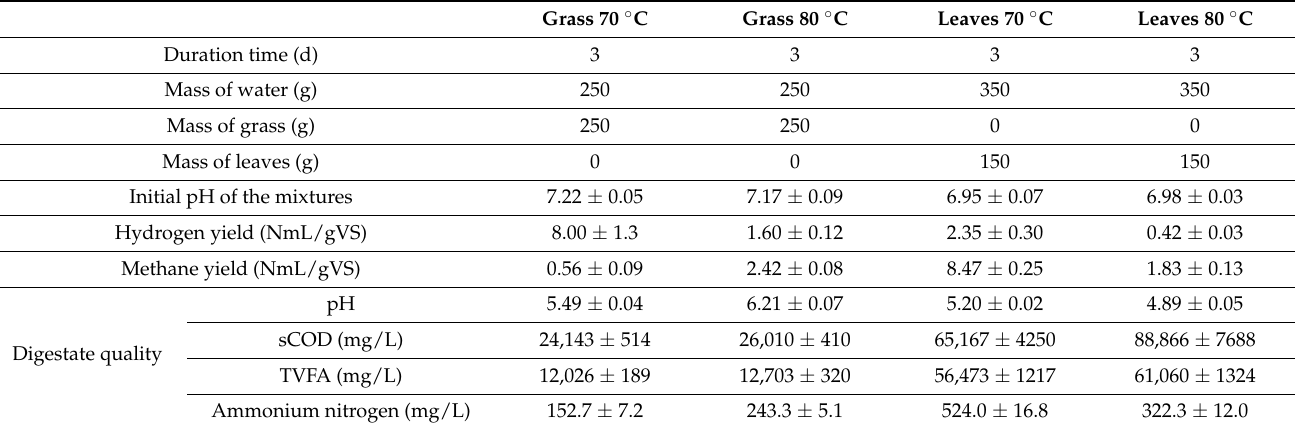
Table 2. Operating parameters, methane and hydrogen yields, and characteristics of digestates of the hyperthermophilic pretreatment